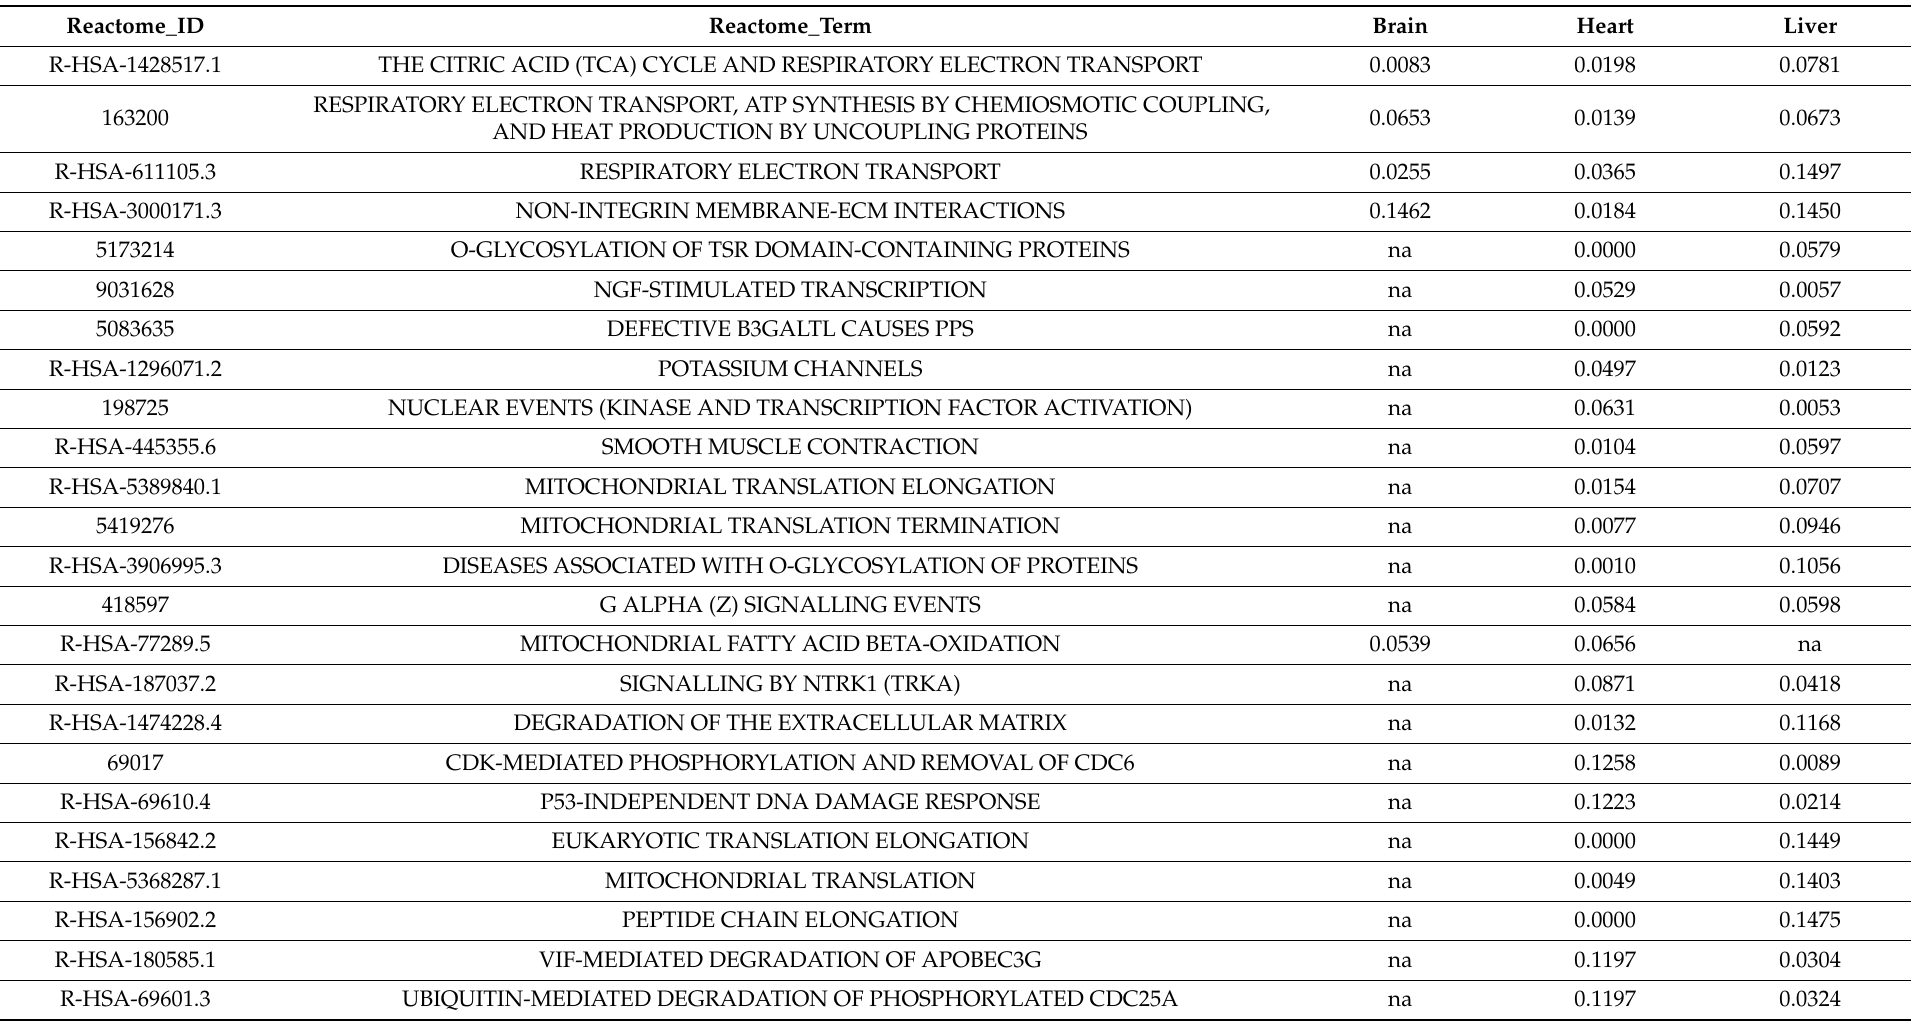
Table 3. Reactome terms commonly enriched in the comparison between heterologous and autologous mtDNA-supplemented-derived pig tissue transcriptome for more than two tissues, analysed by gene sequence enrichment analysis (GSEA). FDR p -values for enrichment analysis are shown. Top 30 terms are listed from Table